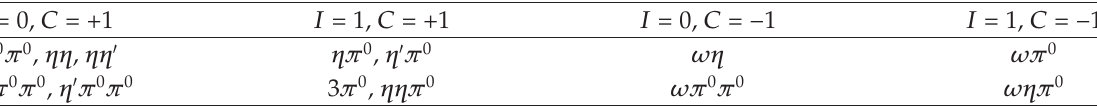
Table 2: Channels to be studied in pp